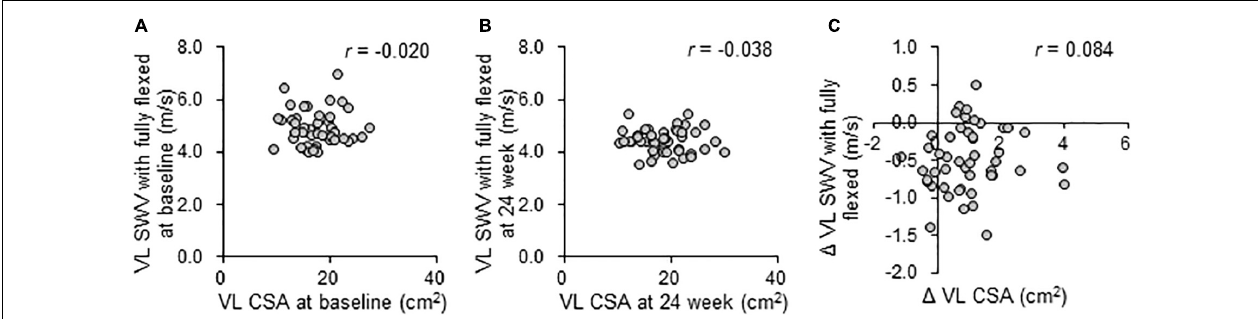
FIGURE 2 | Relationships between muscle quantity and stiffness during the 24-week intervention in the PPS analysis. Pearson’s correlation coefficient ( r ) between VL muscle CSA on MRI and SWV with the knee fully flexed on SWE at baseline (A) and at 24 weeks (B) , and the changes during the 24-week intervention (C) in the PPS analysis. VL, vastus lateralis; CSA, cross-sectional area; and SWV, shear wave